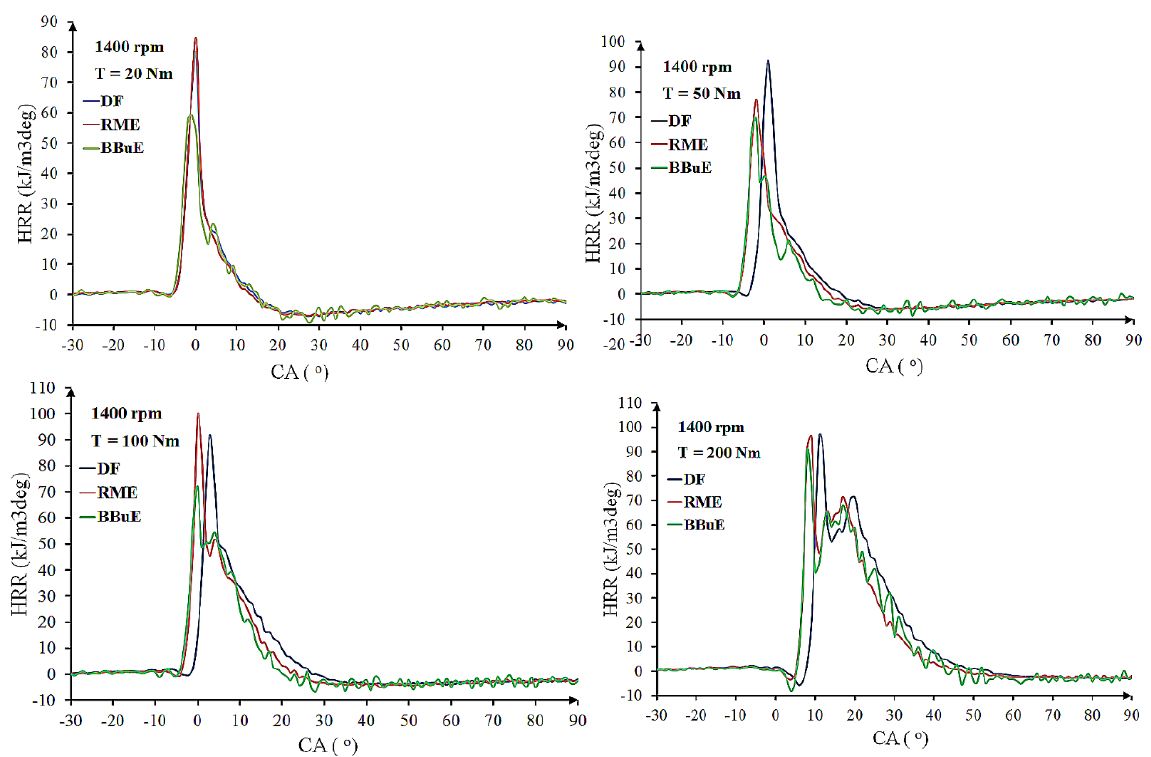
Figure 12. Example characteristics of the heat release rate during the combustion process.